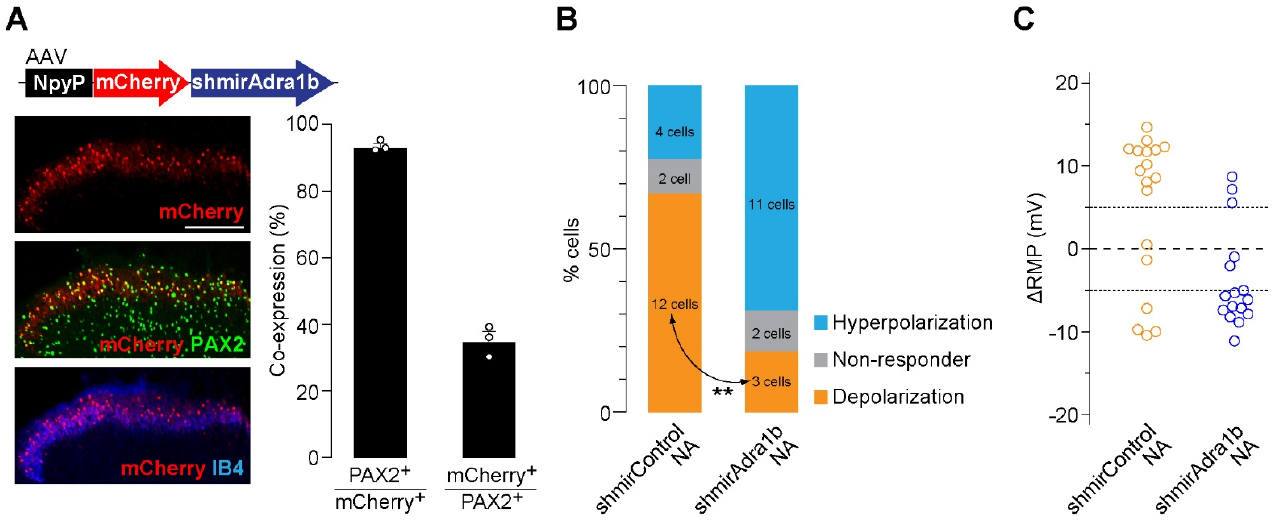
Figure 2. α 1B -AR in AAV − NpyP + neurons is responsible for NA − evoked depolarization. ( A ) mCherry expression on L4 SDH 4 weeks after microinjection of AAV − NpyP − mCherry − shmirAdra1B. Scale bar, 200 µ m. Immunolabeling of mCherry + cells (red) with PAX2 (green) or IB4 (blue). Percentage of co − expressing cells was quantified (680 total mCherry + cells and 1805 total PAX2 + cells from 3 rats). Data shown as mean ± SEM. ( B ) Percentage of AAV − NpyP + neurons responded to NA in AAV − NpyP − shmirControl − or AAV − NpyP − shmirAdra1b − microinjected WT rats ( n = 18 cells from 4 rats for AAV − NpyP − shmirControl, and 16 cells from 5 rats for AAV − NpyP −